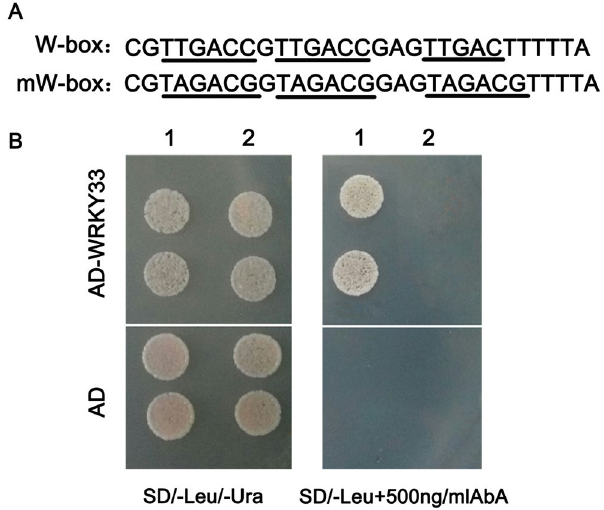
Figure 3. Characterization of GhWRKY33 as a transcriptional factor. ( A ) The sequence of the triple tandem repeats of the W-box and mW-box binding elements. ( B ) Yeast one-hybrid assay using the triple tandem repeats of the W-box and mW-box as bait. Yeast cells carrying pGAD-GhWRKY33 or pGAD7 were grown on SD/- Leu/-Ura or SD/-Leu containing 500 ng/ml AbA. 1: pAbAi-W-box; 2: